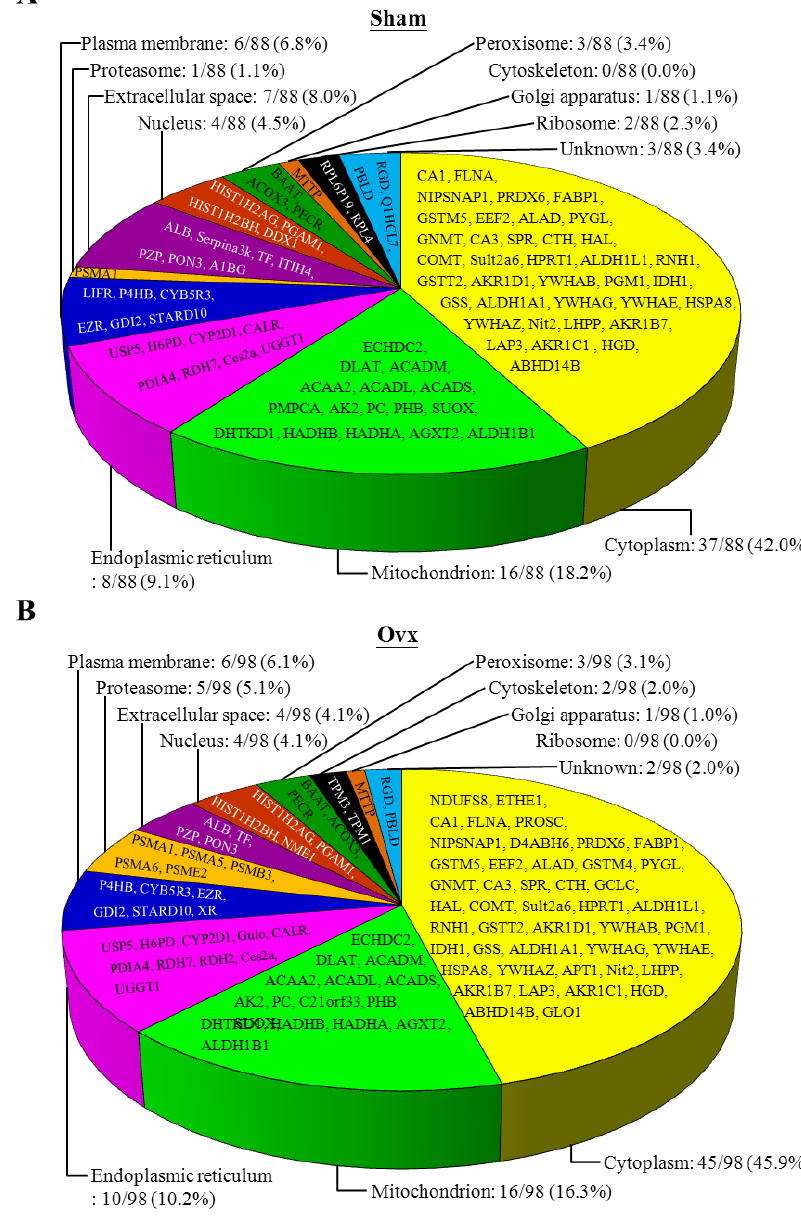
Figure 4. Classification of the differentially expressed proteins identified from Ovx and Sham groups. ( A ) Pie charts representing the distribution of the 88 differential proteins of the Sham group by their cellular location; ( B ) Pie charts representing the distribution of the 98 differential proteins of the Ovx group by their cellular location.